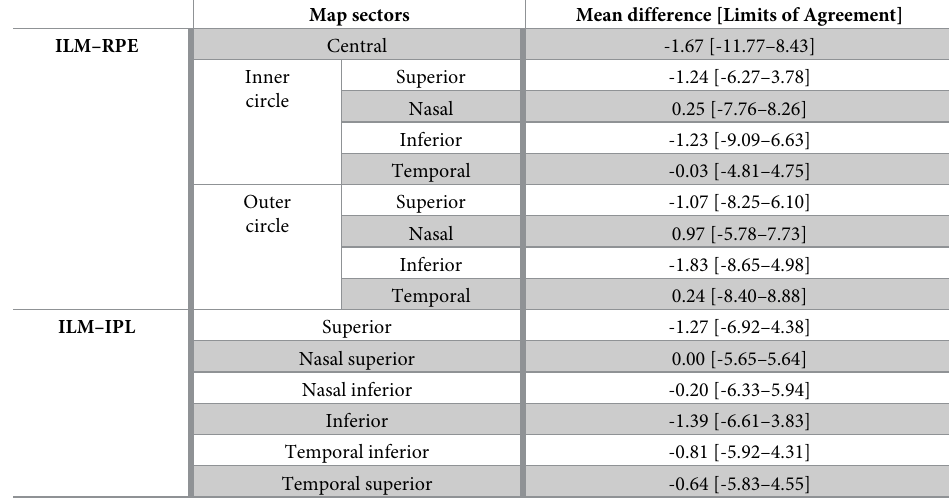
Table 3. Comparison between the horizontal and vertical macular scan.